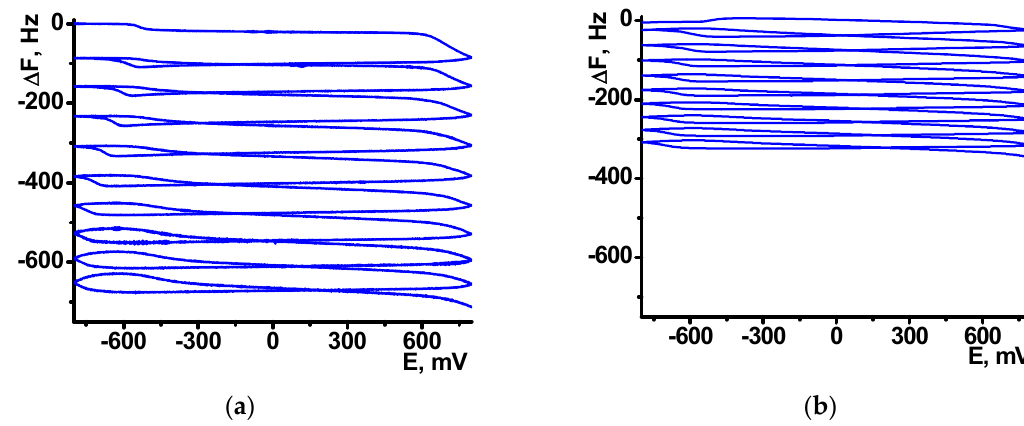
Figure 2. The electrochemical quartz crystal microbalance sensograms recorded on Au electrodes of quartz crystal chip during the multiple cycling of the potential in the 0.4 mM NR solution in 0.025 M phosphate buffer + 0.1 M NaNO 3 (pH = 6.0) in the absence ( a ) and in the presence of 0.2 mg/mL DNA ( b ).